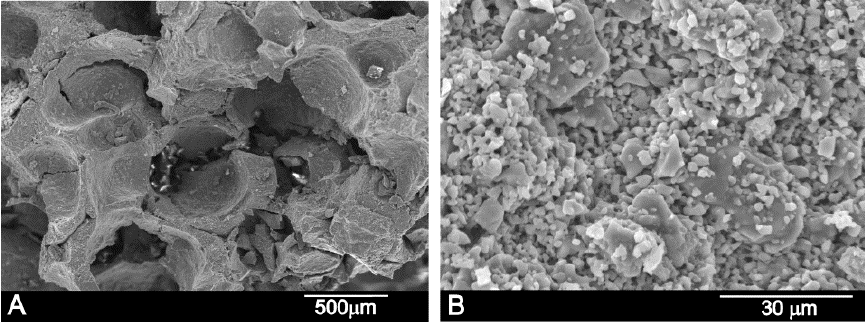
Figure 4. ( A ) SEM and ( B ) high-resolution SEM images of the manufactured CSP scaffold.